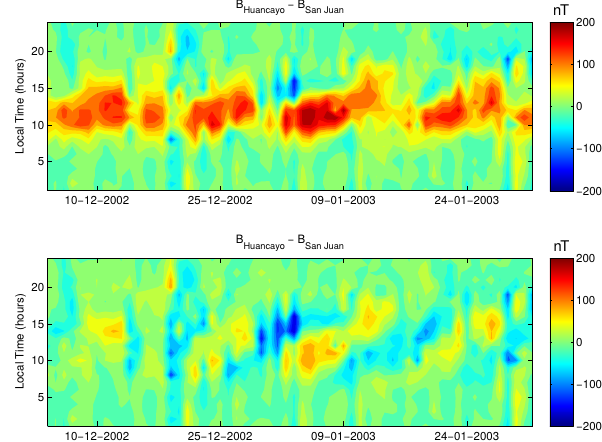
Figure 1. The top frame shows H EEJ obtained from the Huancayo– San Juan pair during December 2002–January 2003 before remov- ing the solar tidal effects. The bottom frame shows the same plot after the removal of solar tidal